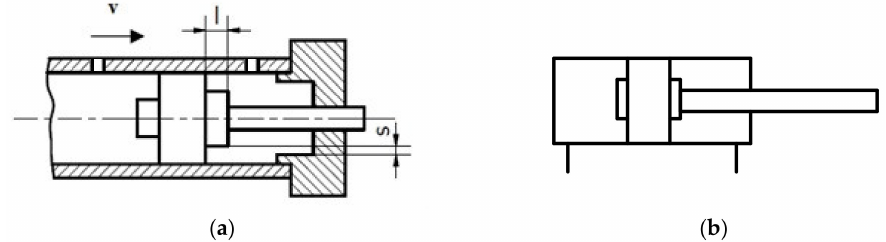
Figure 5. Actuator with a braking gap: ( a ) working principles; ( b ) hydraulic